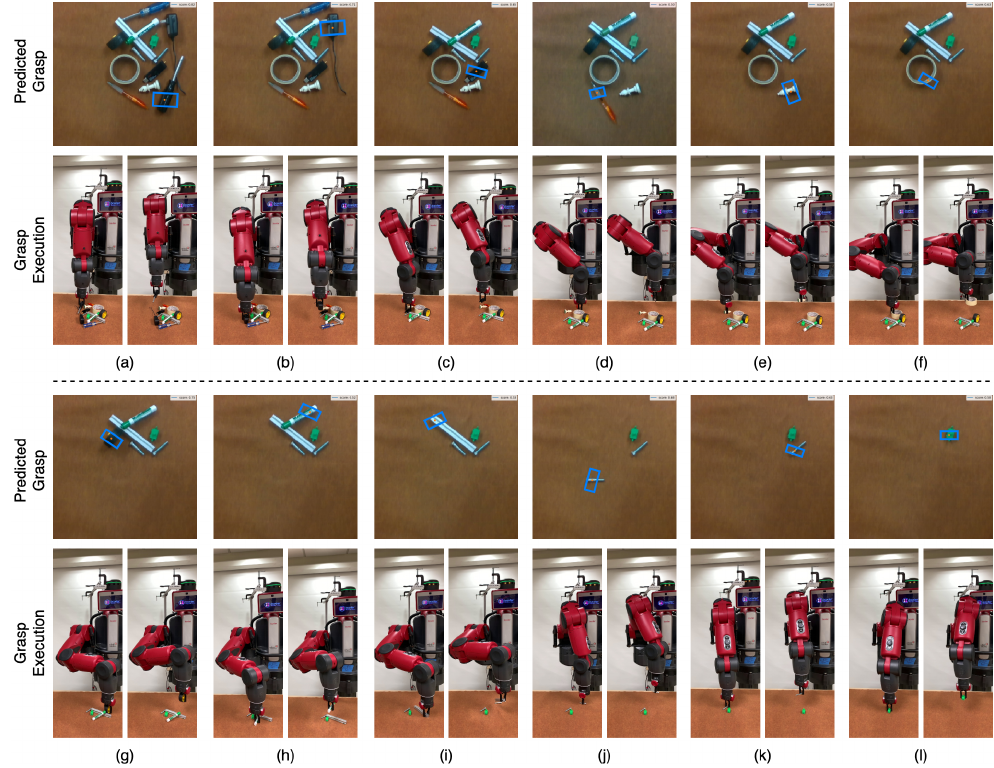
Figure 14. Visualization of the household objects clutter scene removal task in the real world using our GR-Convnet model trained on Cornell dataset. See attached video for a complete run. ( a – l ) show the grasp pose generated by inference module (top), robot grasping the object (bottom left), and robot retracting after successful grasp (bottom right) for each